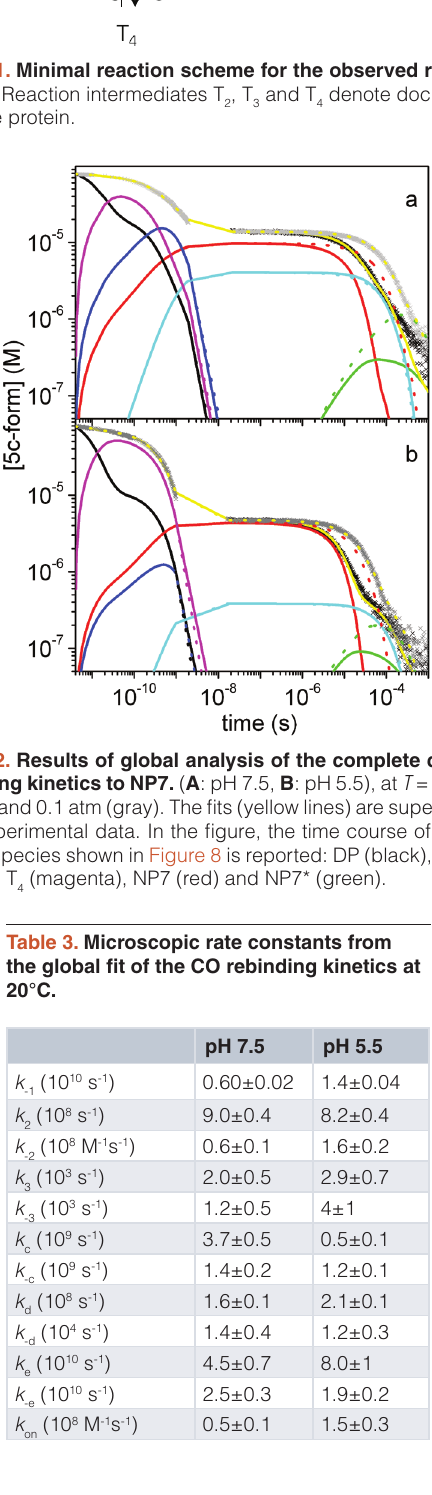
, T and T denote docking sites 2 3 4